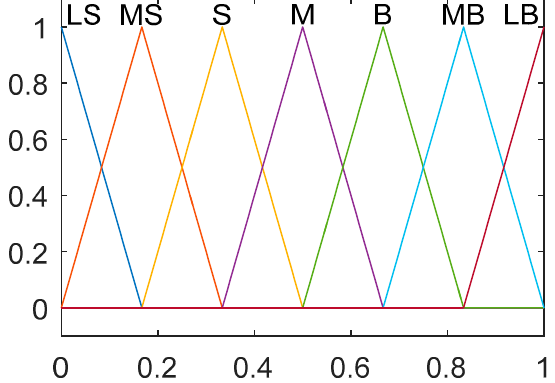
Figure 3. Membership functions for outputs.